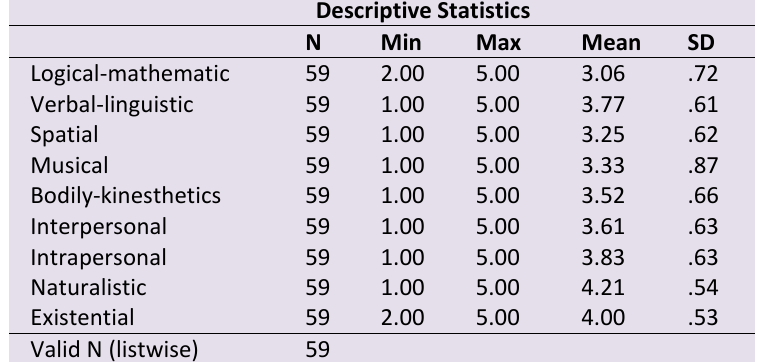
Table 3. Multiple Intelligences of the preservice elementary teachers Descriptive Statistics Descriptive Statistics